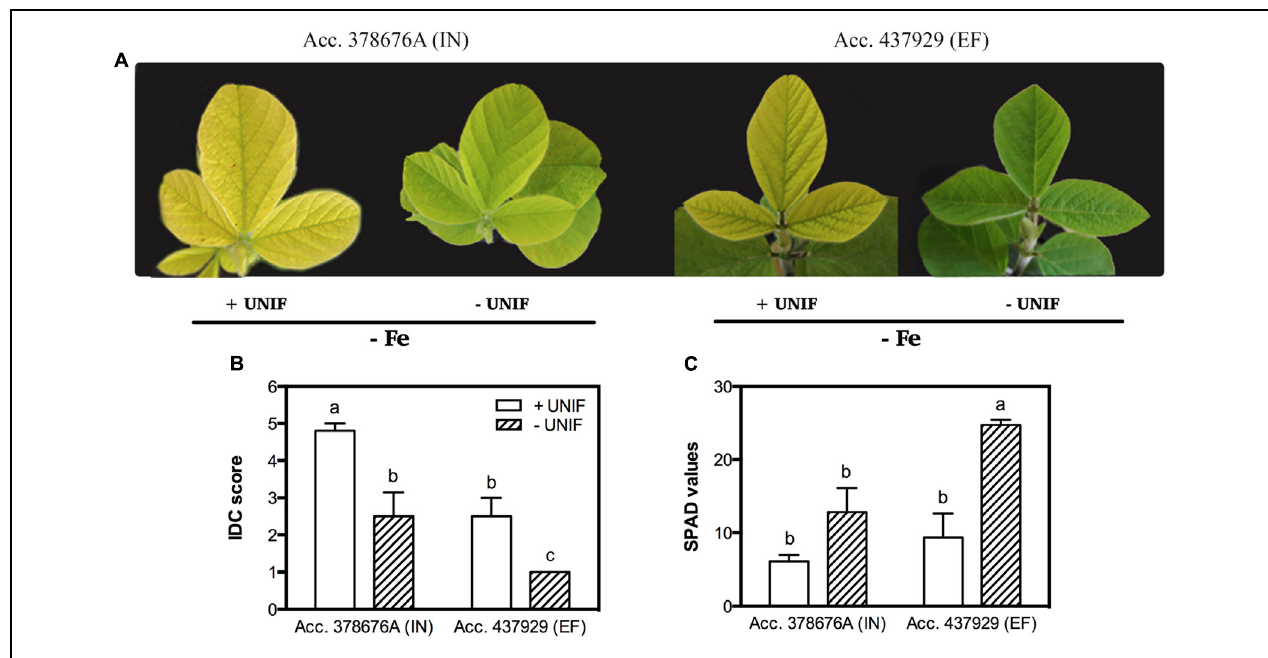
FIGURE 4 | Iron deficiency chlorosis visual symptoms (A), visual IDC score (B) and SPAD values (C) in two G. max accessions [378676A (inefficient) and 437929 (efficient)] grown in Fe-deficient ( − Fe)